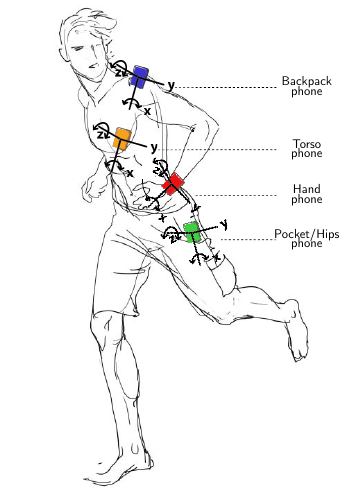
Figure 17. Topology of the on-body sensors deployment featured by the SHL dataset, which is used in the experimental part of this paper. Data collection was performed by each participant using four smartphones simultaneously placed in different body locations: Hand , Torso , Hips , and Bag